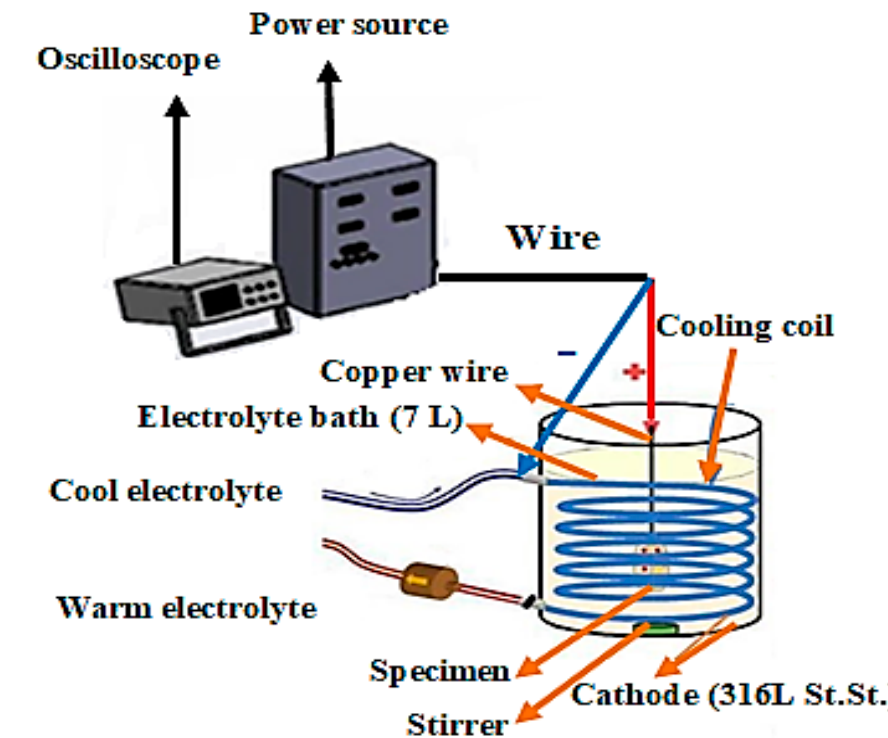
Figure 1. Schematic representation of the plasma electrolytic oxidation (PEO) system and cell components applied for coating.